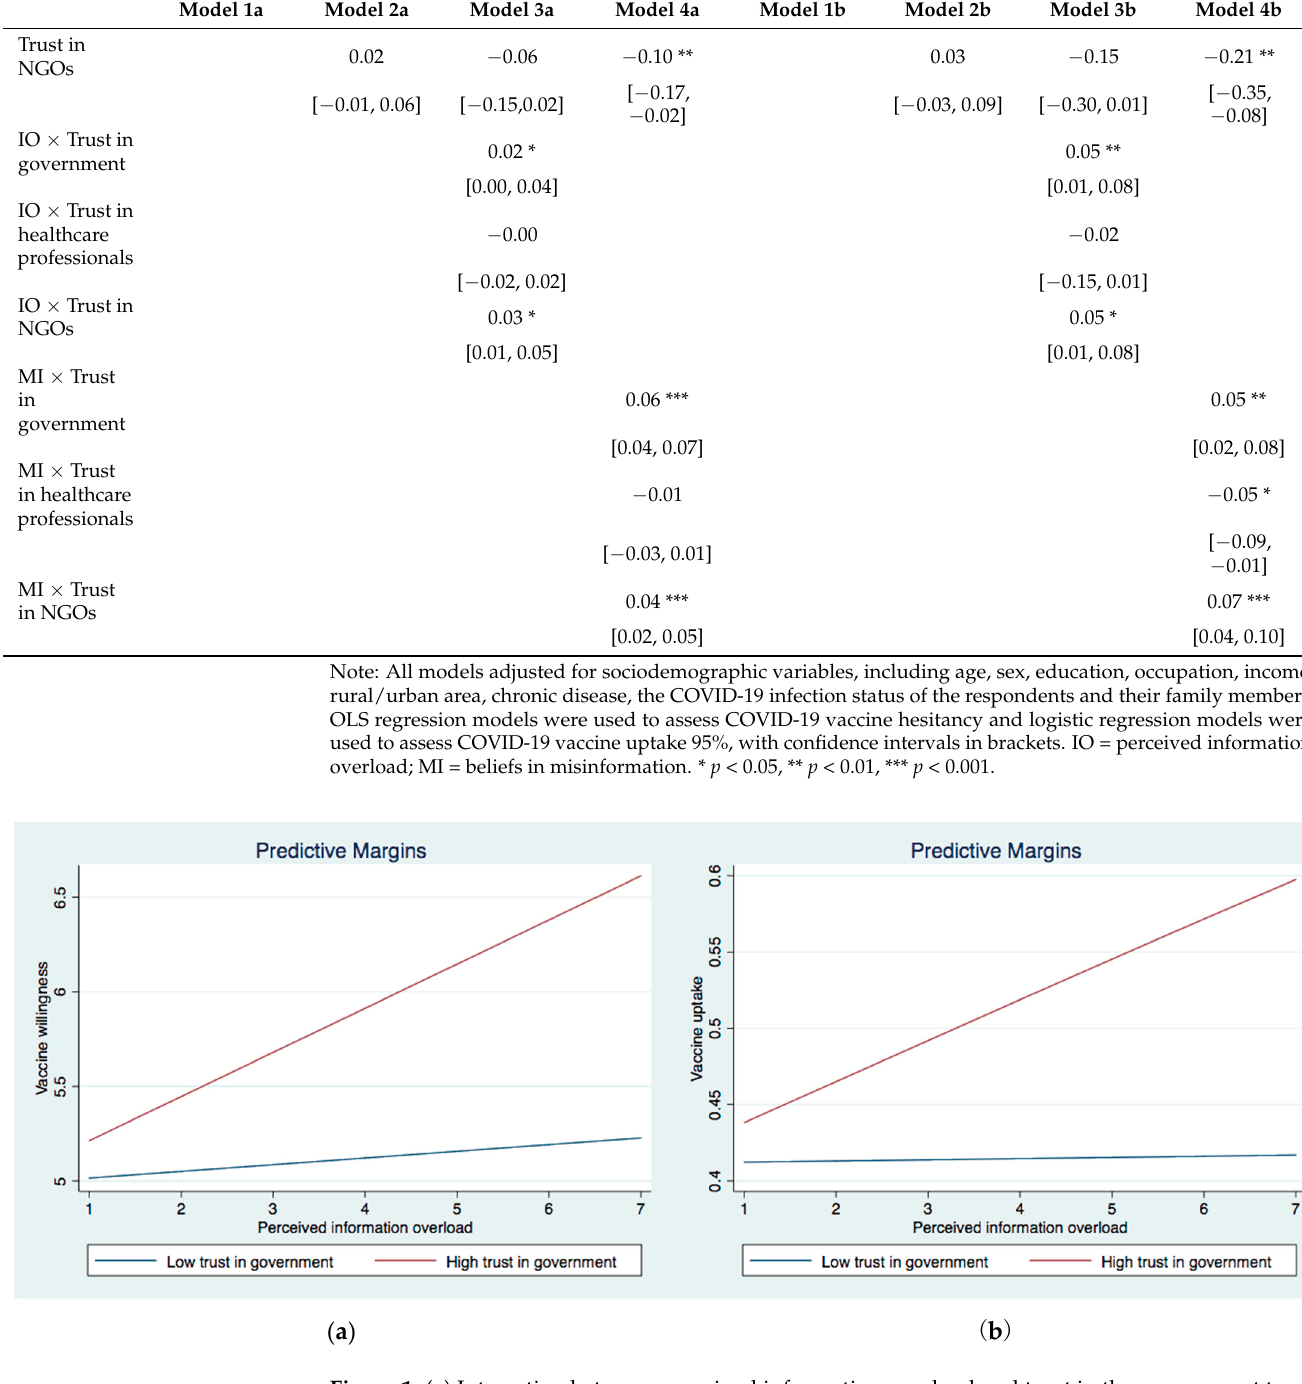
Figure 1. ( a ) Interaction between perceived information overload and trust in the government trust on vaccine willingness. ( b ) Interaction between perceived information overload and trust in the government trust on vaccine uptake.